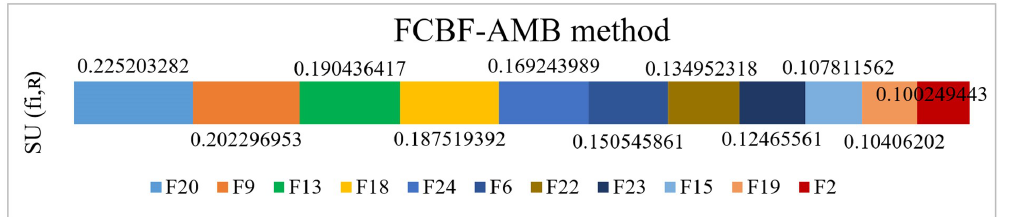
Figure 7. The sensitive features were extracted and sorted in descending order in the feature subset F (cid:48) .